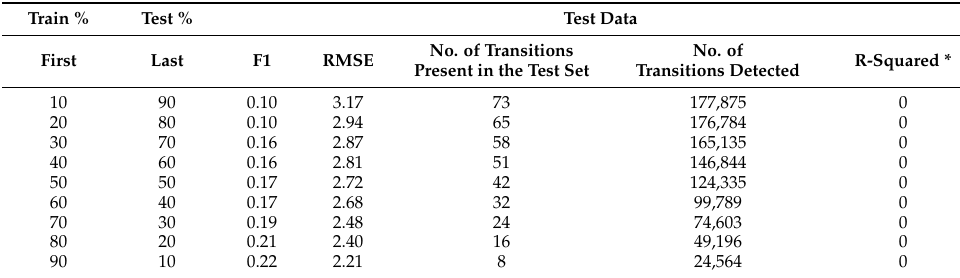
Table 6. Forecasting efficacy of the k-nearest neighbors (k = 3) model for different training and testing partitions.